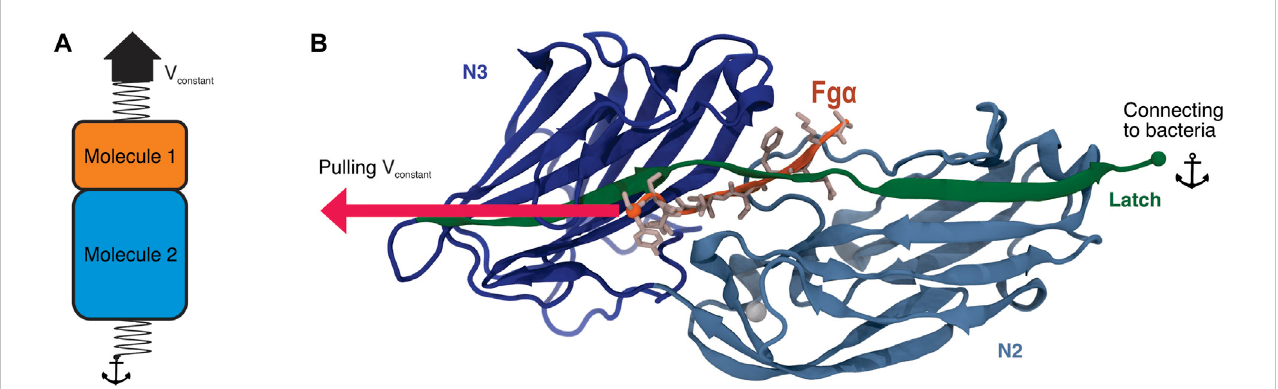
FIGURE 1 Bbp ’ s adhesion domain. (A) Scheme illustrating the SMD protocol applying force at the interface between two molecules of interest. In this protocol, a spring isattachedto oneoftheterminiofeachmolecule, inourcase,theC-terminal end ofbothBbpandFg α peptide. WhiletheendofMolecule twois fi xed, the end of Molecule one is then pulled at constant velocity. (B) Tridimensional structure of Bbp. The protein is represented in cartoon, colored by its different domains. The latch is highlighted in green. Fg α is colored in orange and its aminoacids represented as sticks colored in light pink. The SMD pulling and anchor points are indicated in the image as